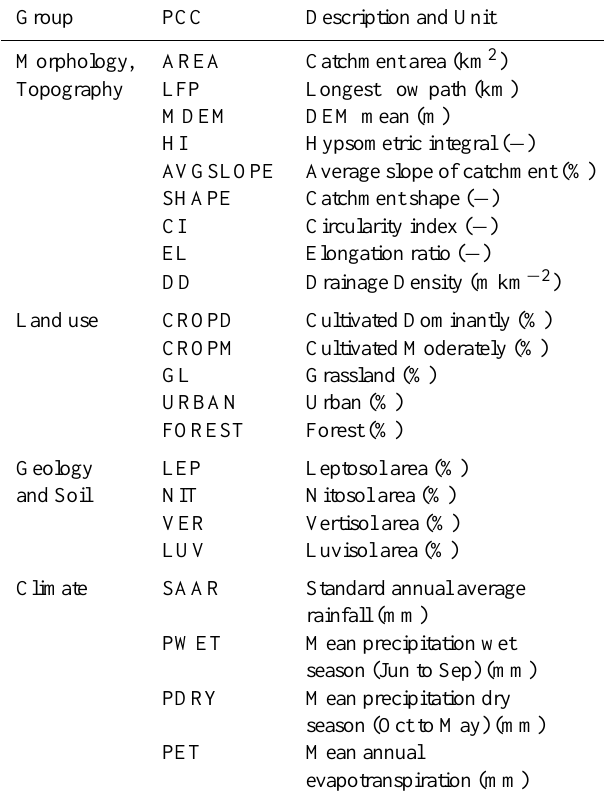
Table 2. Selected physical catchment characteristics